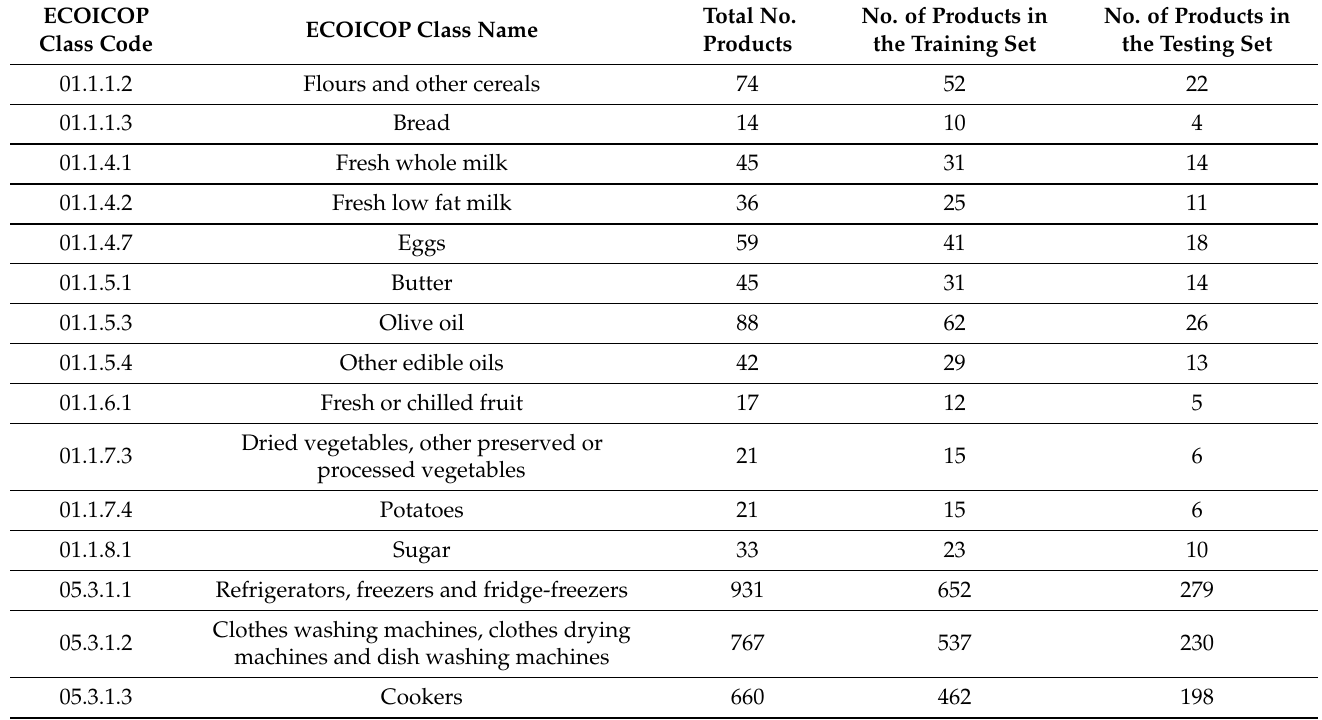
Table 1. The distribution of the selected products among the 15 ECOICOP